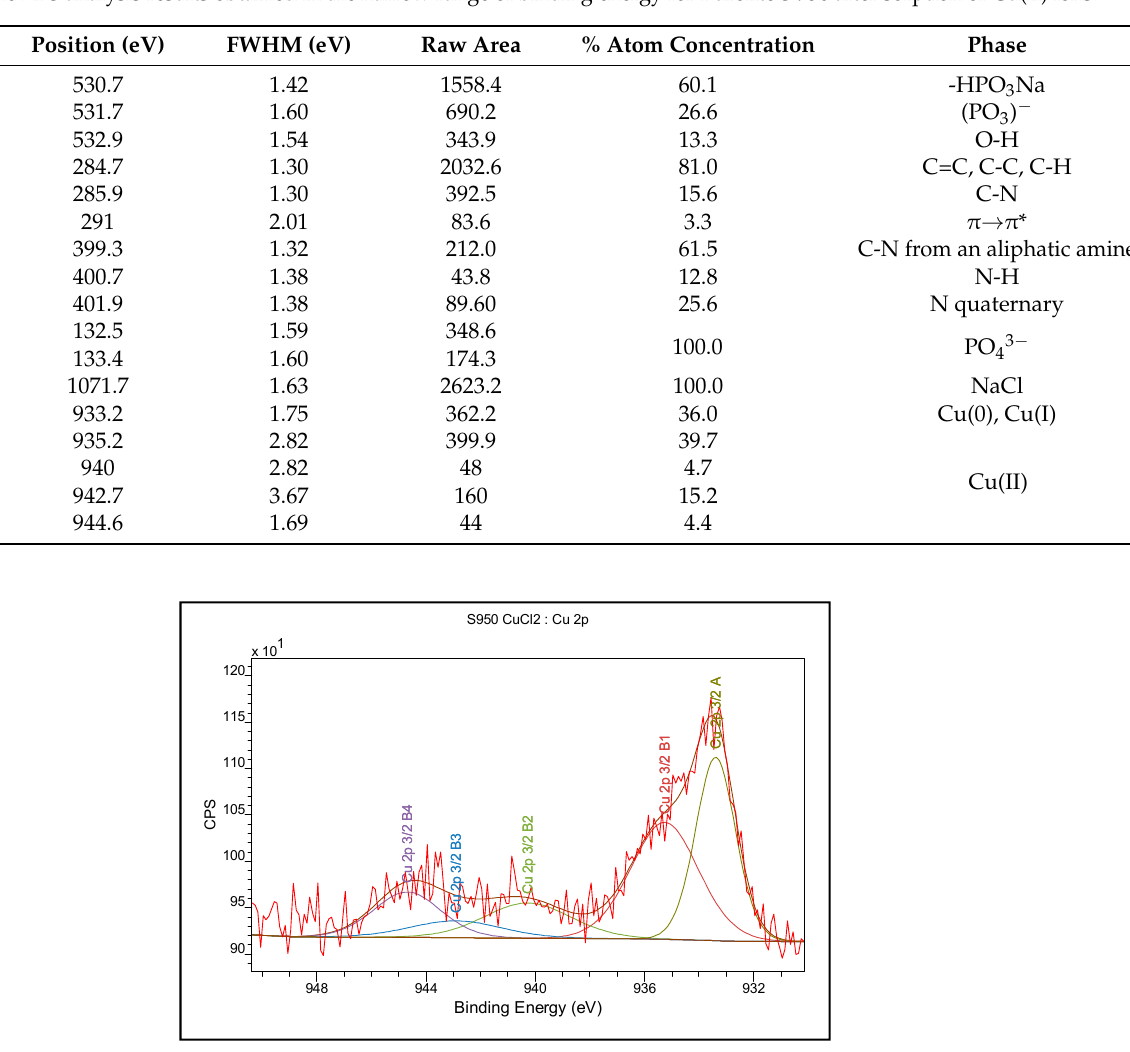
Figure 12. The XPS spectrum obtained in a narrow range of the binding energy for Purolite S 950 after the Cu(II) ion sorption process.